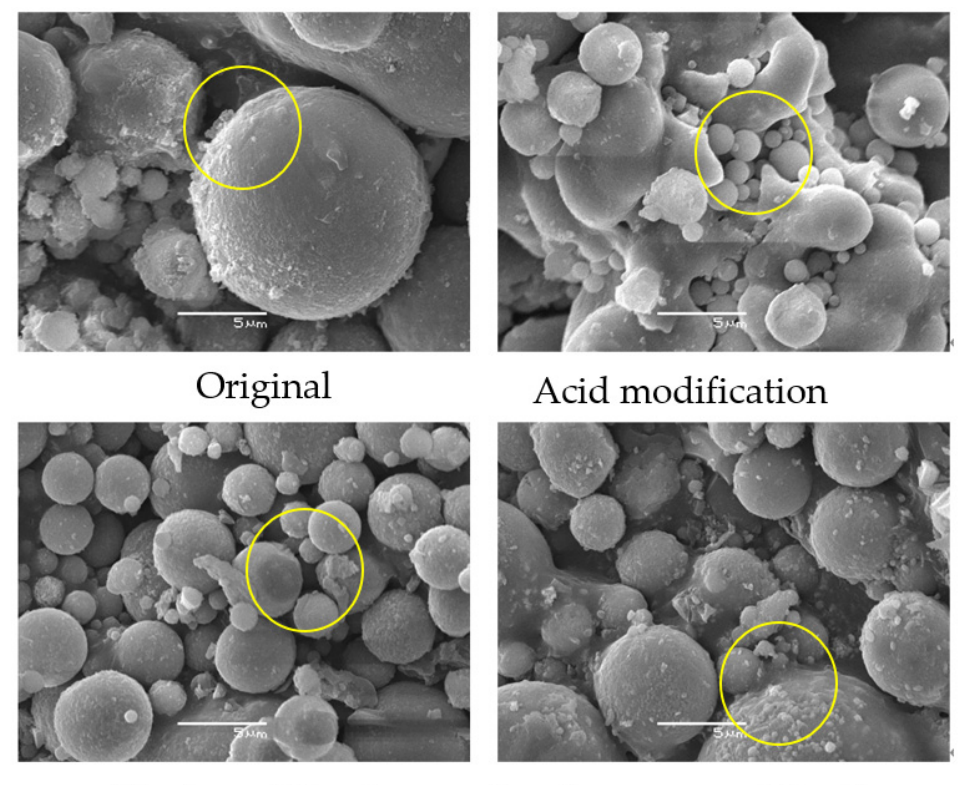
Figure 3. SEM characterization of four types of fly ash.